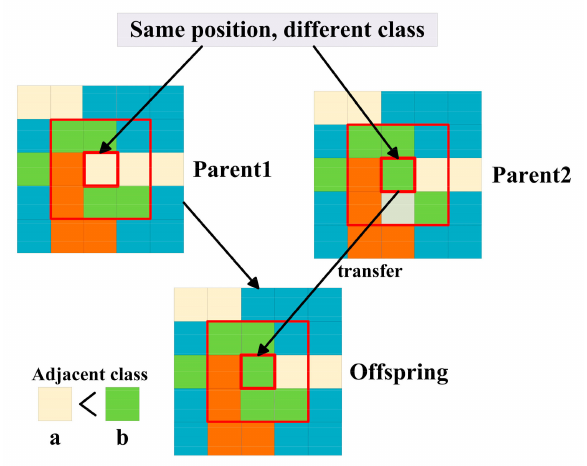
Figure 4. Schematic illustration of the procedure for crossover from two viable parents (Parent1 and Parent2) with two different land uses (a and b respectively) in the center cells. Crossover to form an Offspring is performed by replacing the center cell in Parent1 if the new center cell type outnumbers the old.